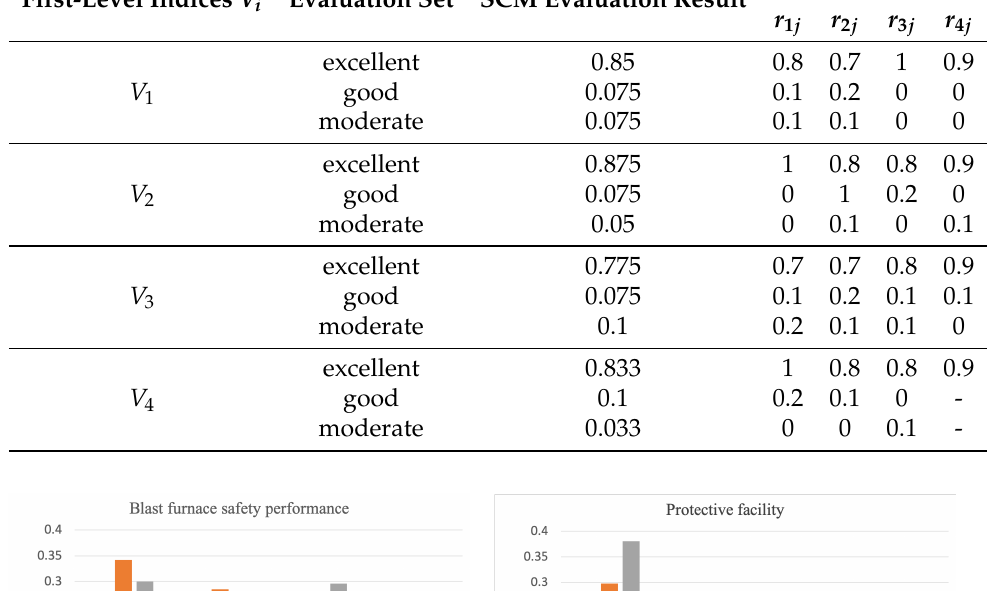
Table 6. Evaluation value of the safety checklist method.